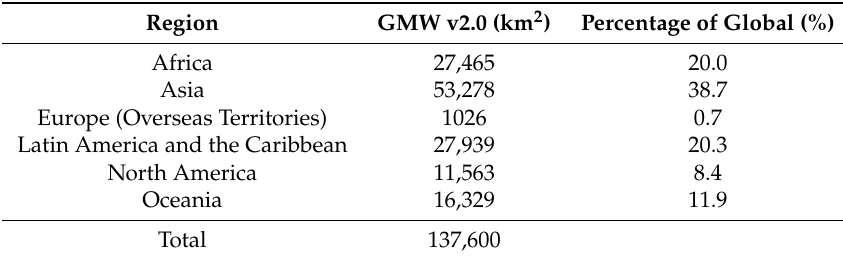
Figure 5. Example GMW v2.0 maps, using the Open Street Map (https://www.openstreetmap.org) data as background mapping. From west to east: ( A ) Central America (Honduras/Nicaragua); ( B ) Africa (Madagascar); and ( C ) Australia (Queensland). The maps are presented in WGS-84 (epsg:4326) with coordinates in decimal degrees (valid for all figures below). Table 3. GMW v2.0 baseline extents for the six Ramsar